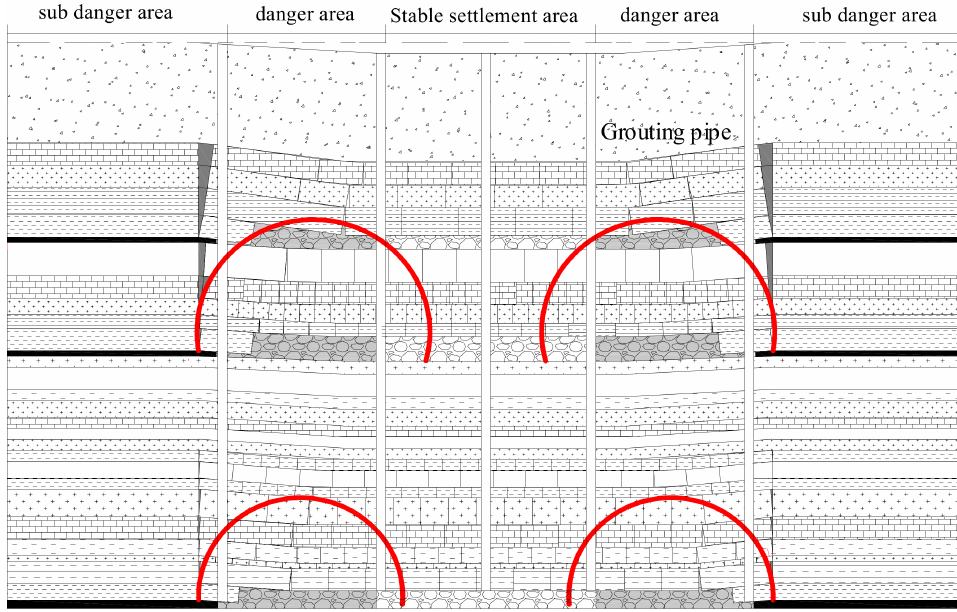
Figure 25. Key areas of grouting reinforcement in the study